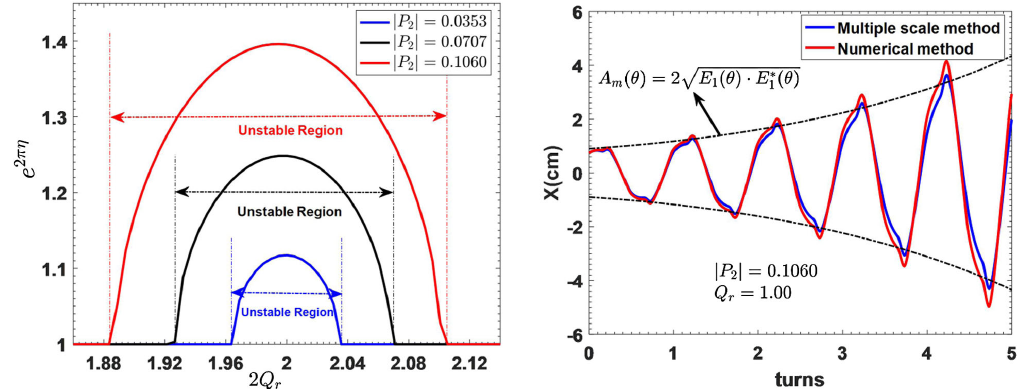
and increasing rate of the amplitude e 2 πη for different second r